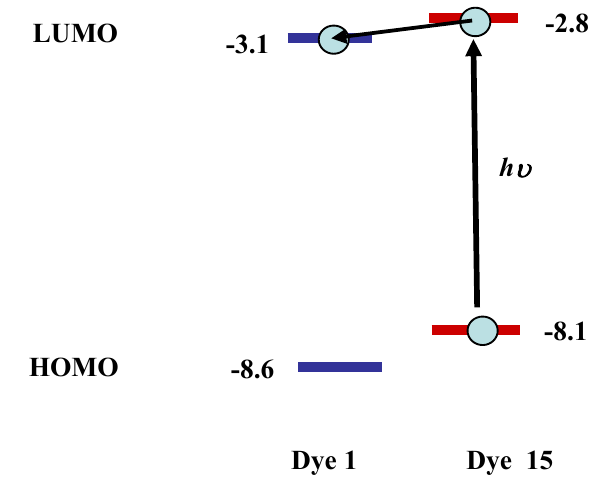
Figure 9. The calculated energy levels (eV) of anthraquinone dye 1 and coumarin dye 15 .